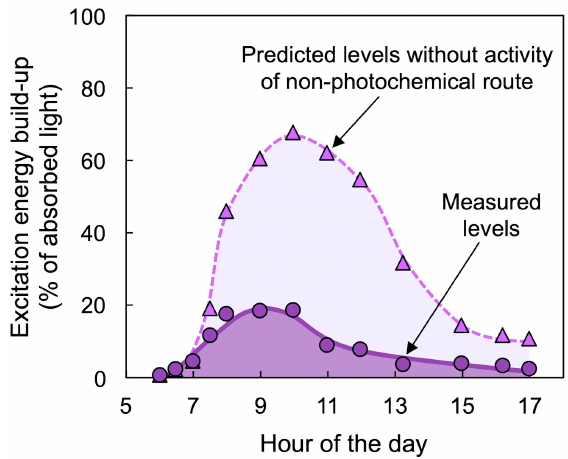
Figure 8. Levels of measured (quantified from chlorophyll fluorescence as photosystem II reduction state; purple circles) and predicted (calculated for the absence of non-photochemical energy dissipation; purple triangles) build-up of excess excitation energy over the course of a day in the east-facing surface of a cactus ( Nopalea cochenillifera ) cladode. Data are from Demmig-Adams and Adams [19].